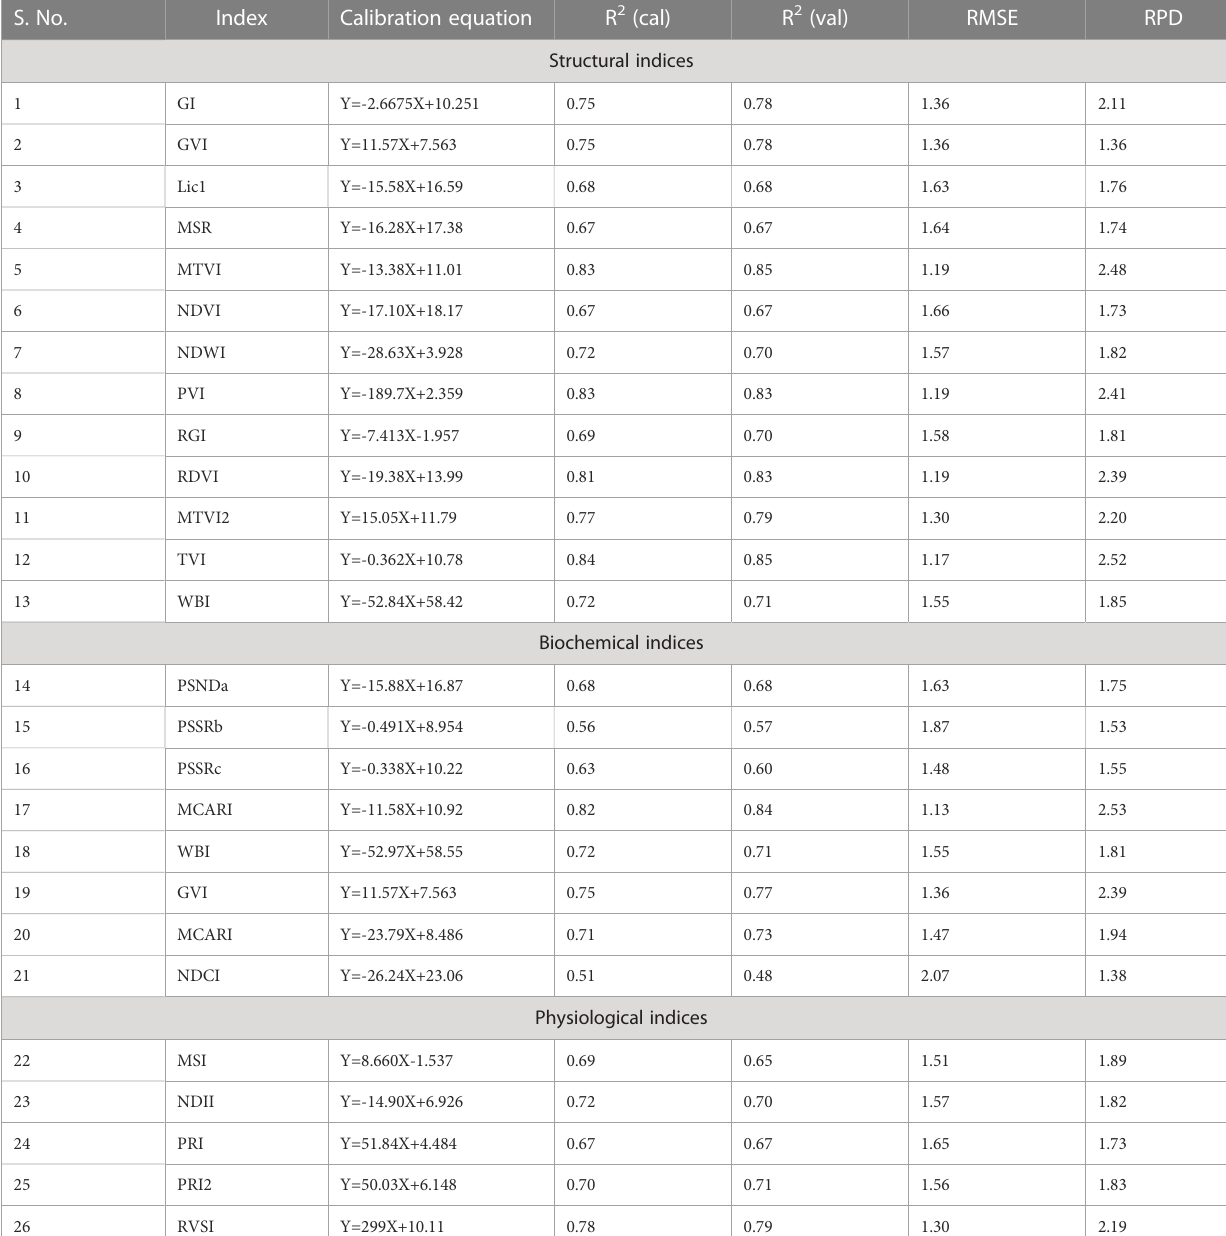
TABLE 7 Regression model for disease prediction using spectral